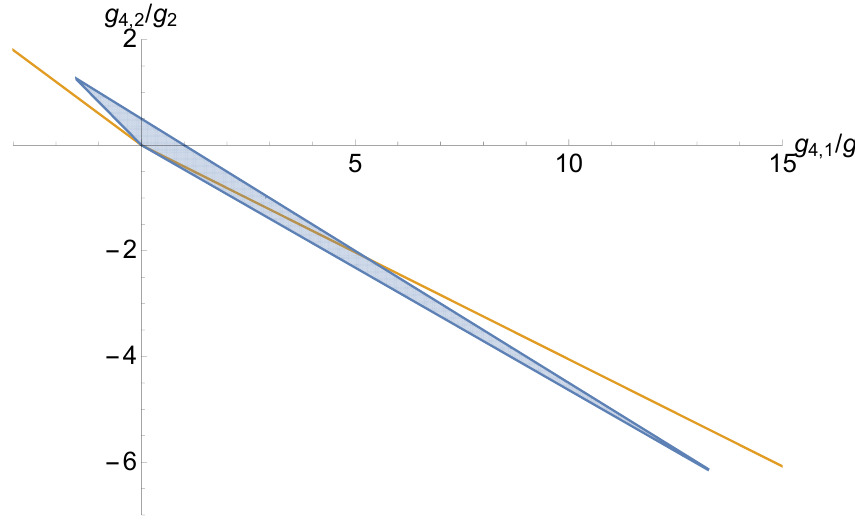
Figure 4 . Showing the triangle with the vertices given by (4.18), and, in orange, the bound (4.19) from [4], where allowed region is above the